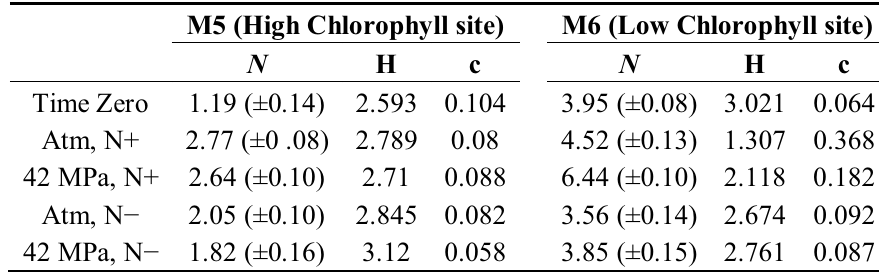
Table 2. Total counts (N), diversity (H) and dominance (c) for prokaryotic communities. Values refer to bacteria and archaea combined. Diversity indices were calculated